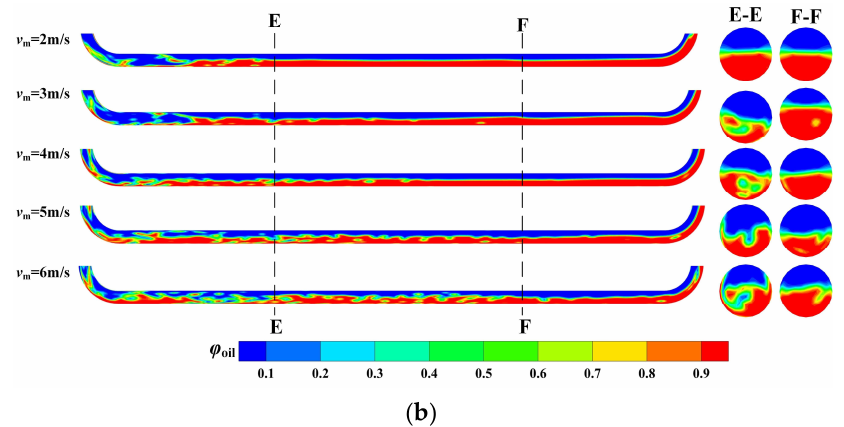
Figure 17. Comparison of flow regimes at different inlet velocities, where ϕ gas is the gas void fraction, v m is the mixture velocity, and E-E and F-F denote two selected cross-sections along the bottom horizontal tube: ( a ) flow regimes in the jumper when the periodically stable flow is achieved; ( b ) contours of oil volume fraction in the bottom tube and the zoom-in view of two considered cross-sections.